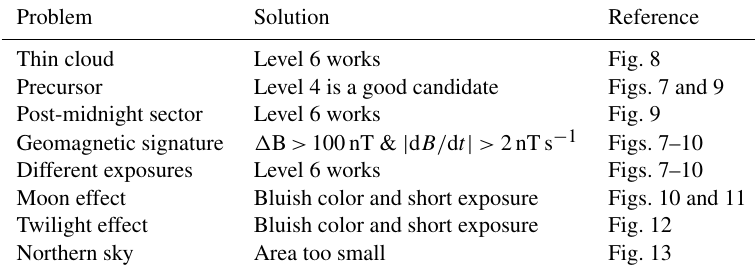
Table 8. Summary of examples.